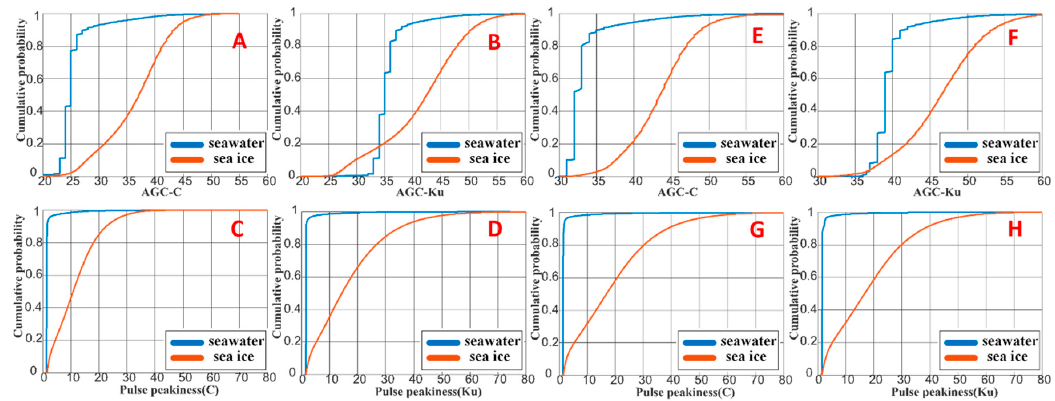
Figure 9. Cumulative probability distributions for the four cases (open ice, young ice, old ice, and ambiguous ice) for the four waveform parameters: AGC of the C Band; AGC of the Ku Band; PP of the C Band; PP of the Ku Band. Note: A – D are the results of the HY-2A; E – H are the results of the